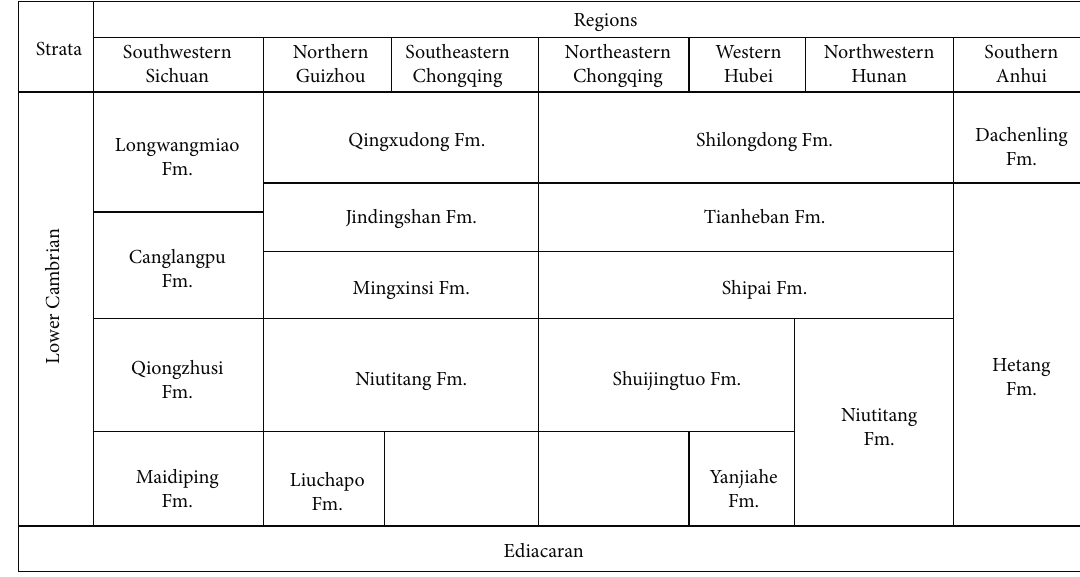
Figure 3: Stratigraphic division and correlation of the Lower Cambrian typical plays (modi fi ed from Zhu et al. [45]; Hu et al. [48]; Zhang et al. [49]; Zhao et al.